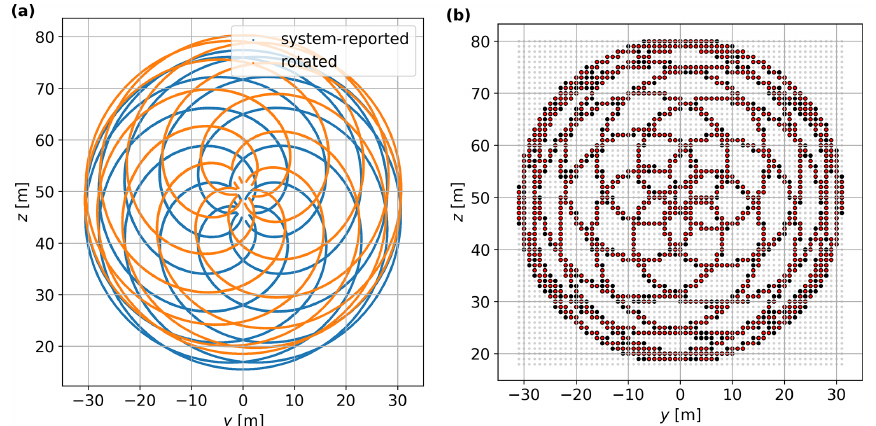
Figure 6. (a) Scan locations (before and after rotation) in an arbitrary 10min period. (b) Gridding of the scans within the same 10min period. Grid cells with more than 30 radial velocity spectra are marked in red. Other details are given in the text.